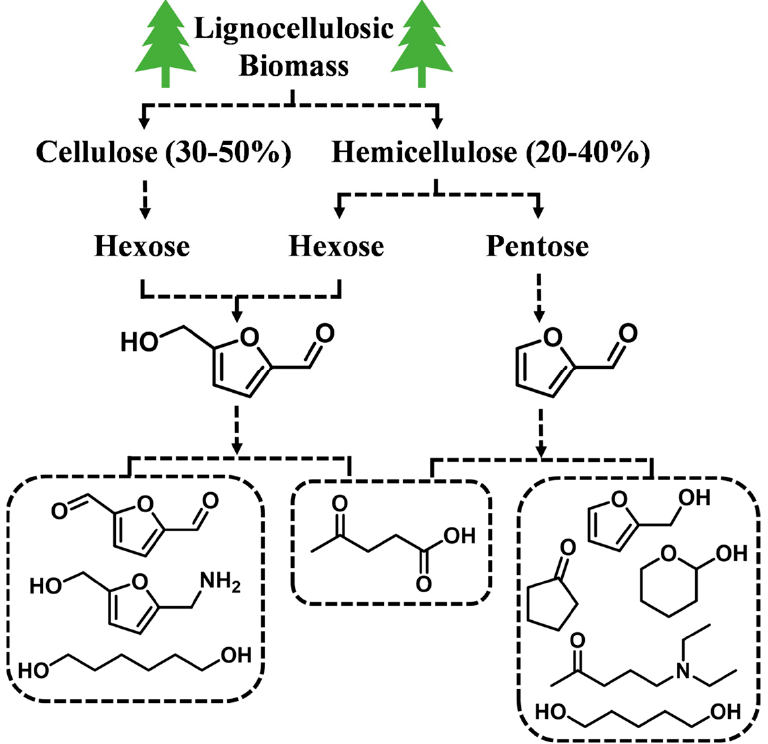
Figure 1. Schematic representation of bio-based furanic oxygenates.